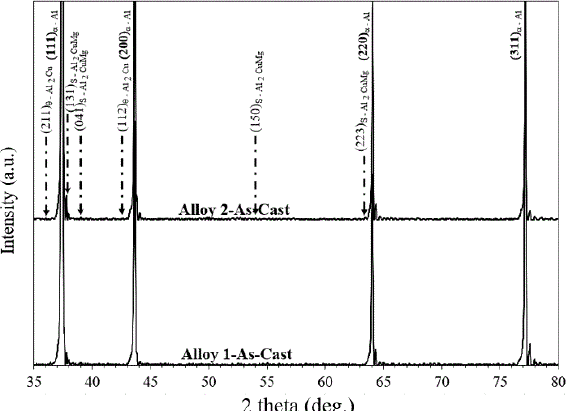
Figure 1. X-ray diffraction patterns of the as-cast state Al-Cu-Mg-Ag alloys.